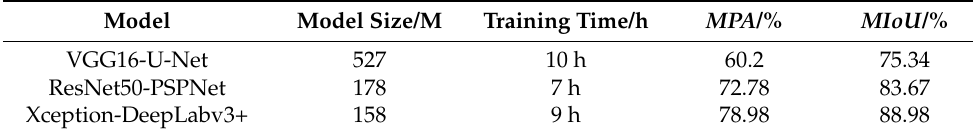
Table 1. Comparison of three different semantic segmentation